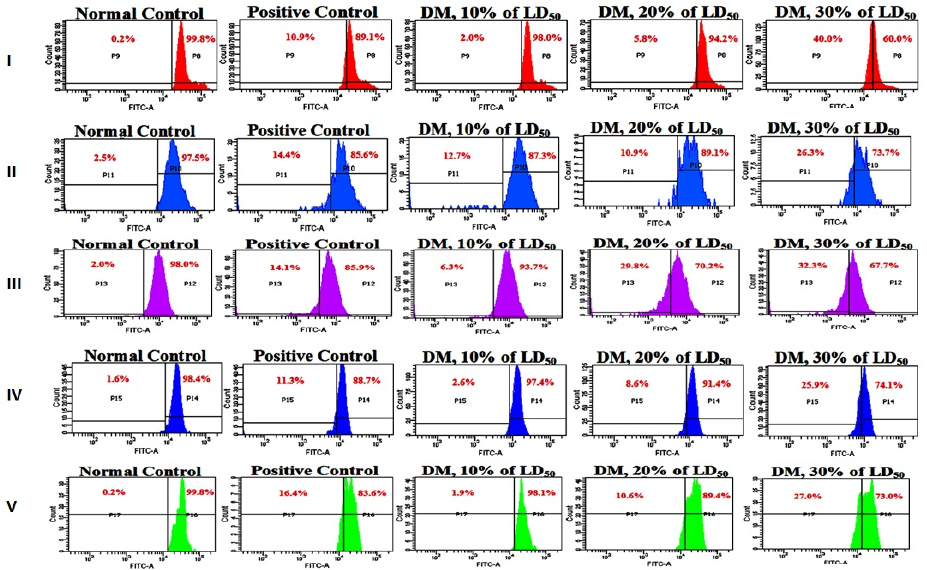
Figure 7. Outcome of Dimethoate treatment on mitochondrial membrane potential ( ∆Ψ m) loss in WBCs of R. norvegicus . Characteristic FACS images from an experiment depicting Rh 123 fluorescence as a function of DM concentrations. P8 and P9, P10 and P11, P12 andP13, P14 and P15, P16 and P17 represent percentage of intact and reduced mitochondrial membrane potential in ( I ) Neutrophils, ( II ) Monocytes, ( III ) Lymphocytes, ( IV ) Platelets, ( V ) Eosinophils respectively.